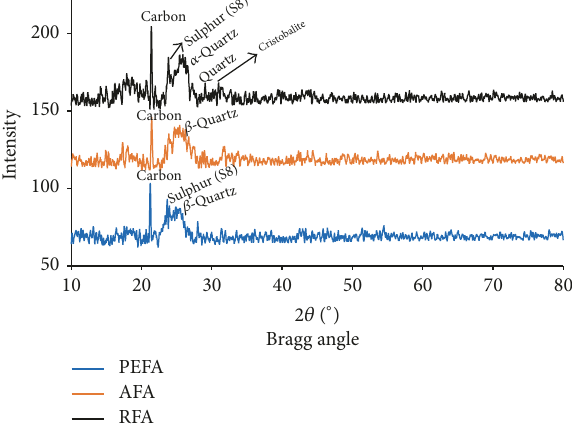
Figure 7: XRD spectra of RFA, AFA, and